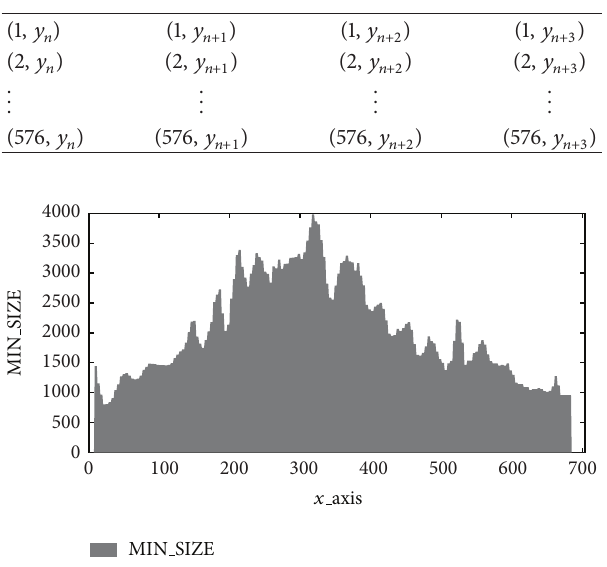
Table 4: Pixels in a big group.